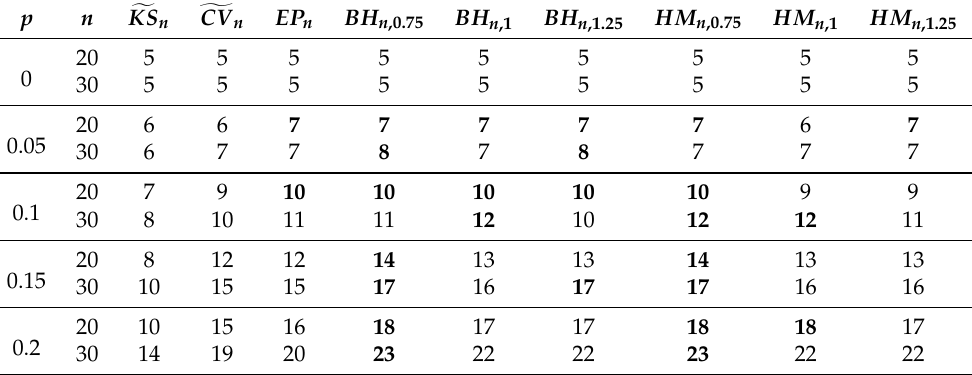
Table 3. Estimated local powers for the mixture of the Rayleigh and exponential distributions, using transformed data, for various choices of the mixture parameter, p